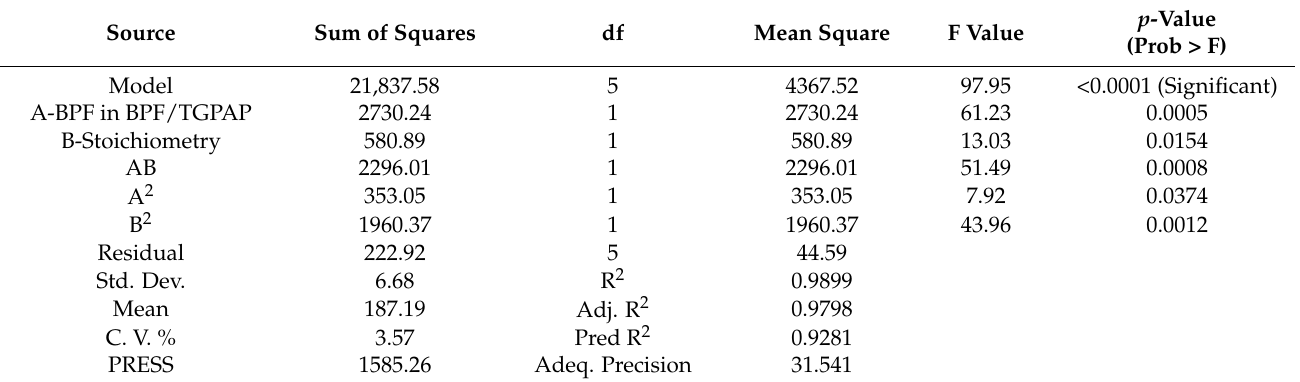
Table 3. ANOVA table for the surface response quadratic model (response: T g